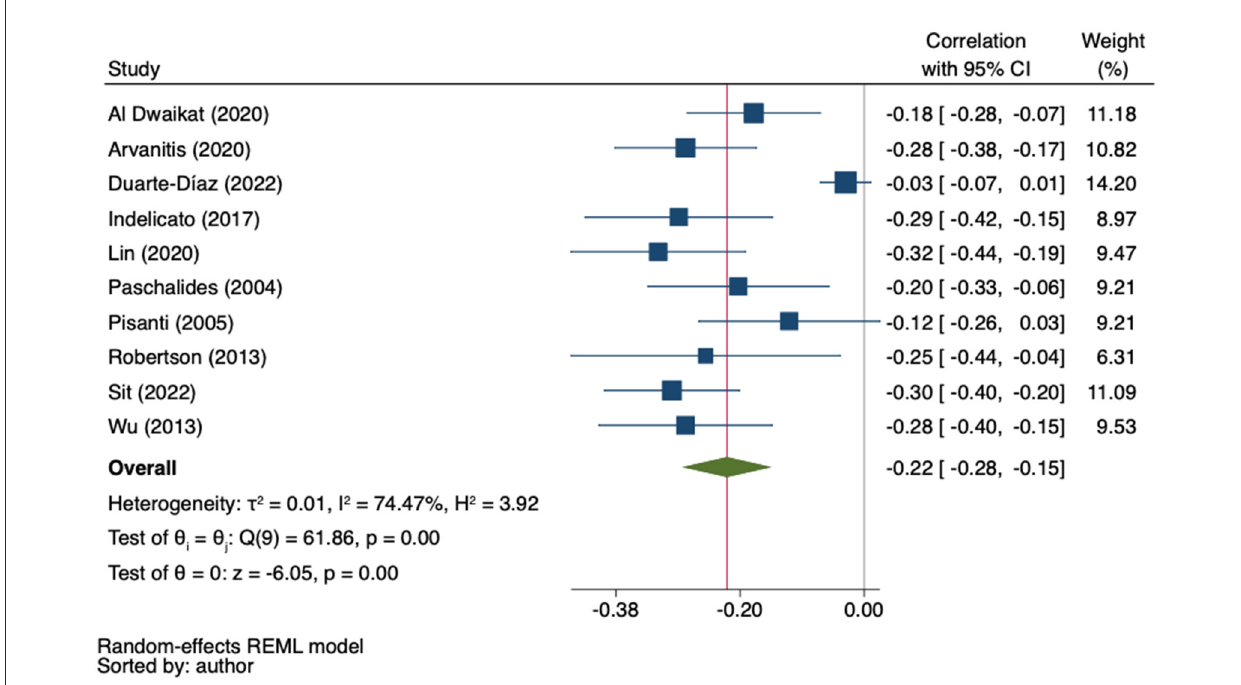
FIGURE3 Random-effects meta-analysis on the association between empowerment and anxiety.